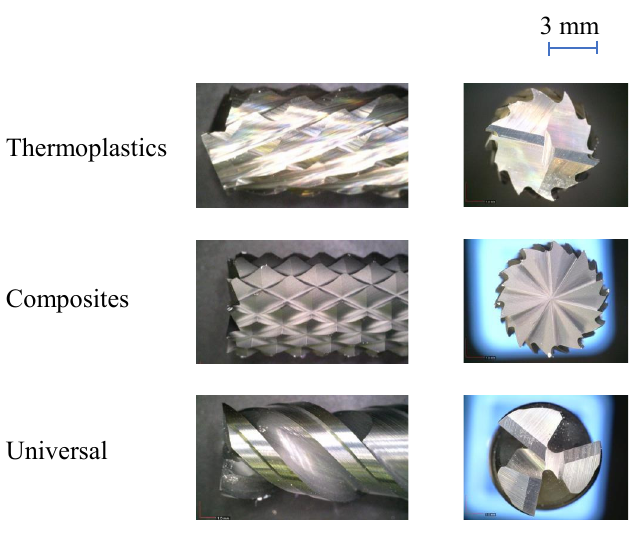
Figure 5. Geometry of the thermoplastic, composite, and universal